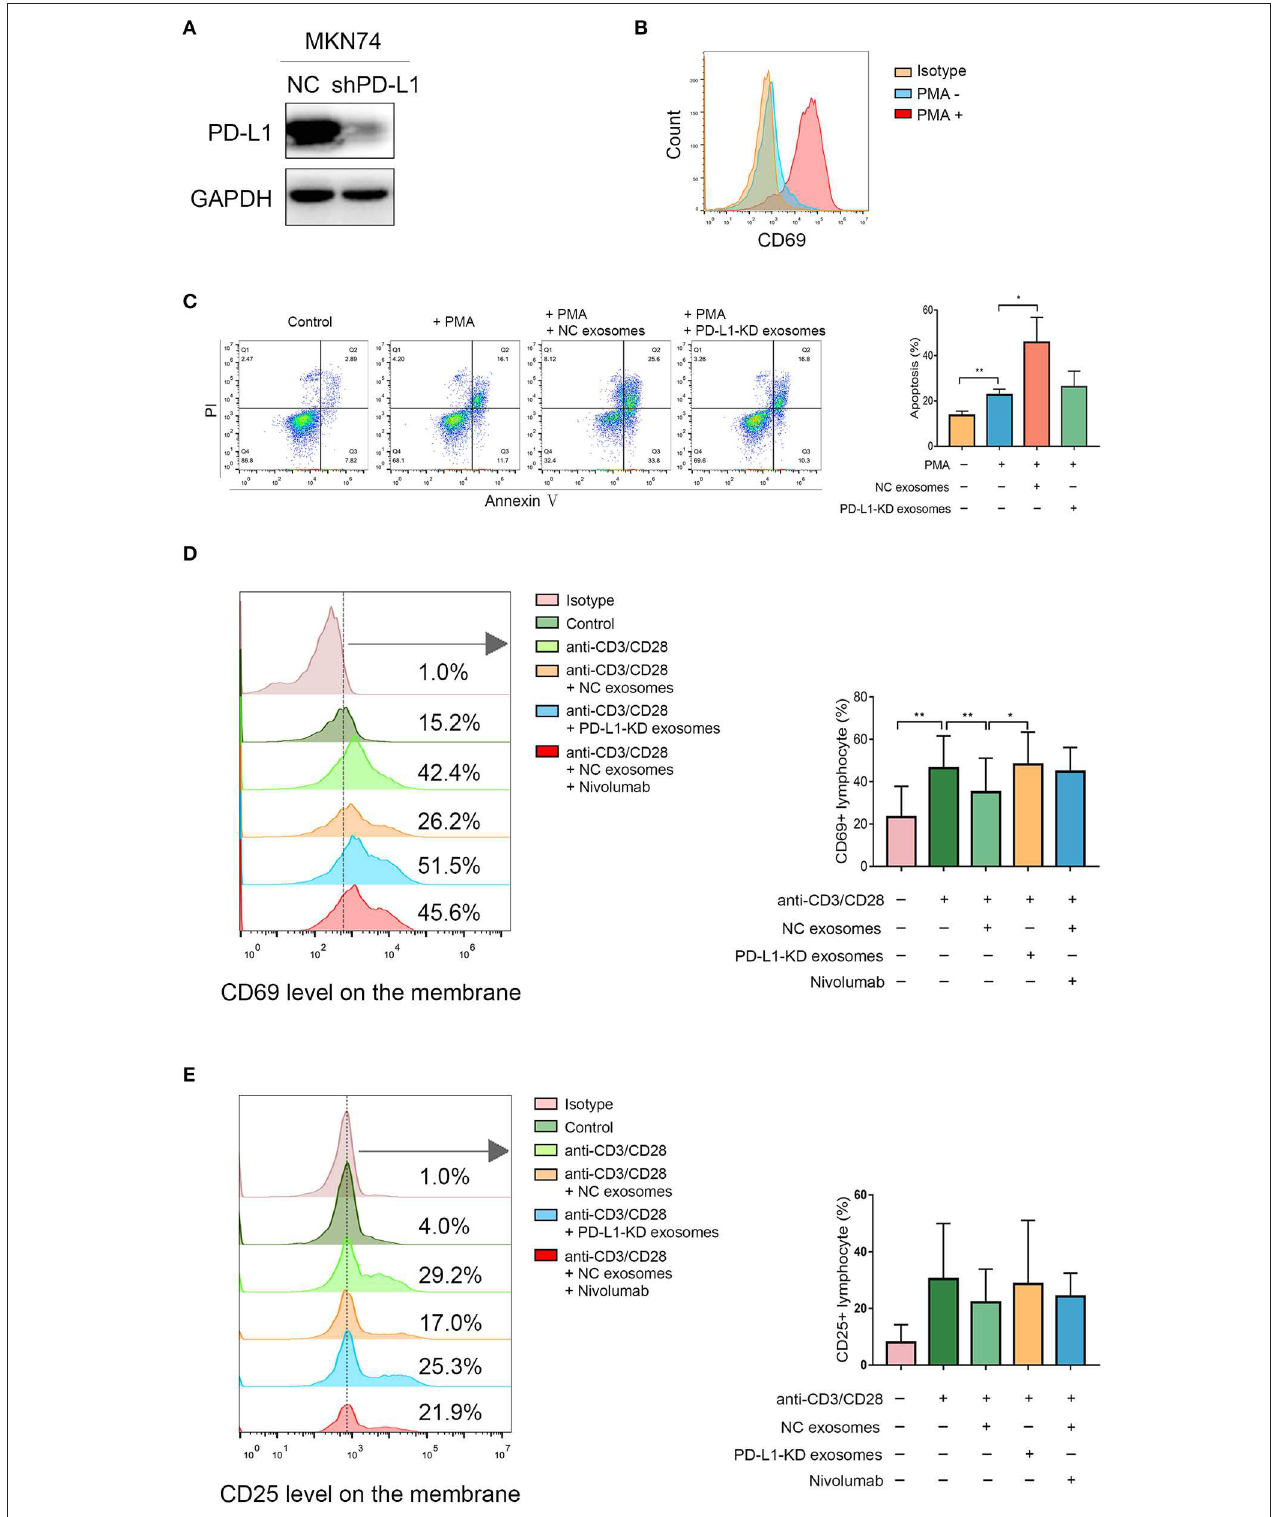
FIGURE 4 | Exosomal programmed death-ligand 1 (PD-L1) induces Jurkat T cell apoptosis and suppresses T cell activation in peripheral blood mononuclear cells (PBMCs). (A) Western blot showed knockdown effect of PD-L1 in MKN74 cells. (B) Jurkat T cells were treated with 50ng/ml phorbol 12-myristate 13-acetate (PMA)